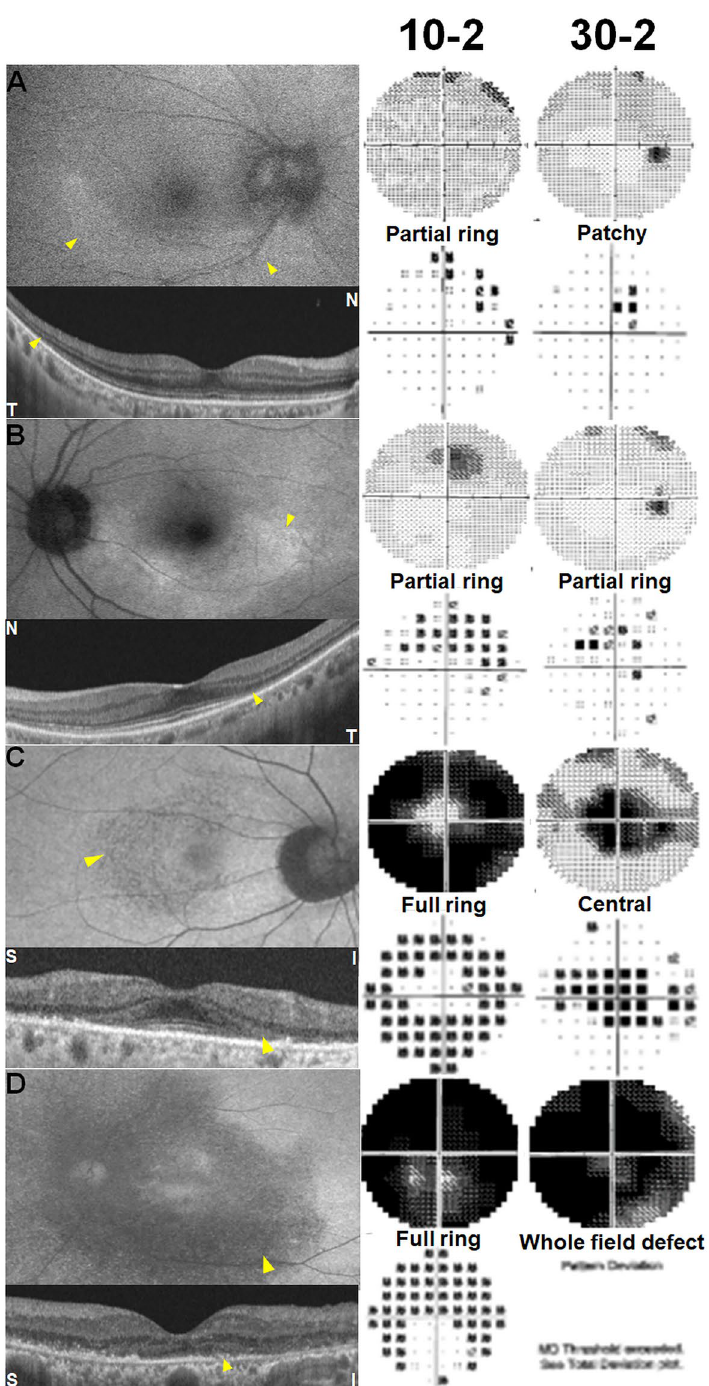
Figure 1. Representative examples of scotoma patterns noted in 10-2 and 30-2 Humphrey visual field (VF) tests noted in 4 patients with hydroxychloroquine retinopathy: patchy scotoma, partial- or full-ring scotoma, ring scotoma, central scotoma, and whole-field defect. In each case, results from fundus autofluorescence (FAF, top left), optical coherence tomography (OCT, bottom left), grayscale map (top right, with text of VF protocol), and pattern deviation map (bottom right) are presented. All patients showed abnormalities, including photoreceptor loss on OCT, and hyper- or hypo-autofluorescence on FAF in the parafoveal or pericentral areas. Yellow arrowheads indicate the areas of retinal damage. N = nasal; T = temporal; S = superior; I =